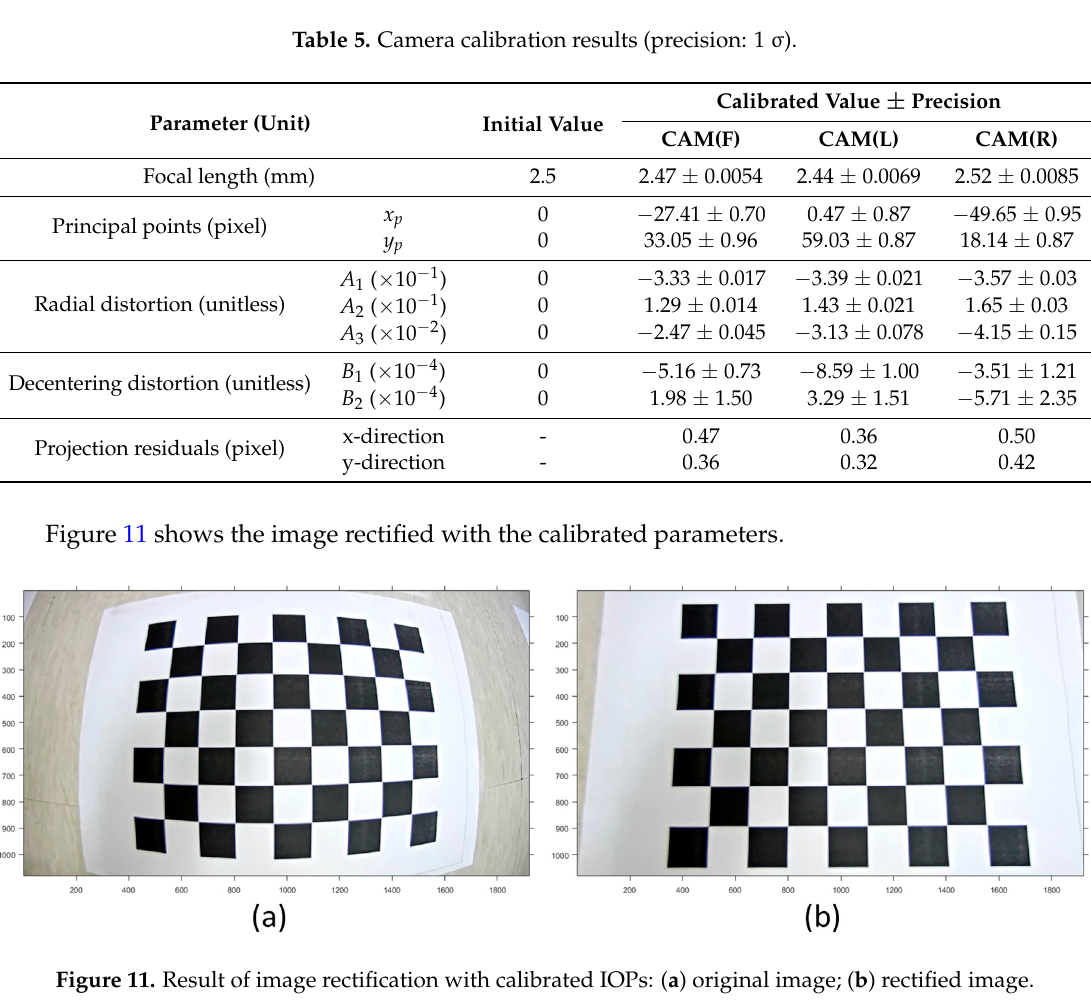
Table 6. Boresight and lever-arm calibration results (precision: 1 σ ). extracted from the images were below 1 pixel, the discrepancy between the plane model and the points transformed using the estimated parameters was 12